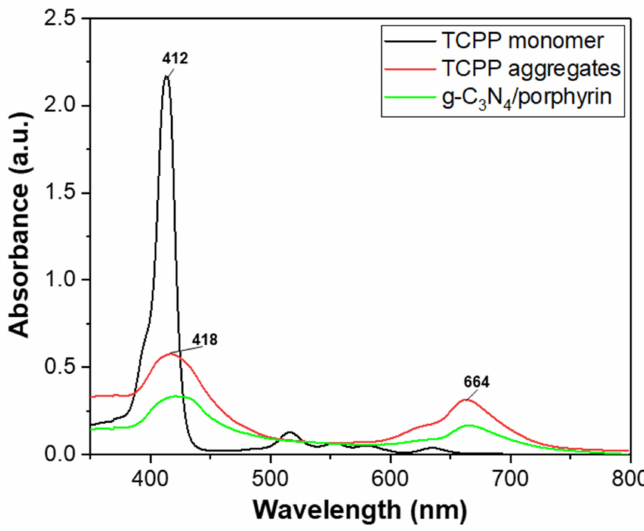
Figure 1. UV-Vis spectra of porphyrin monomer, free-standing self-assembled TCPP, and g-C 3 N 4 /porphyrin hybrid